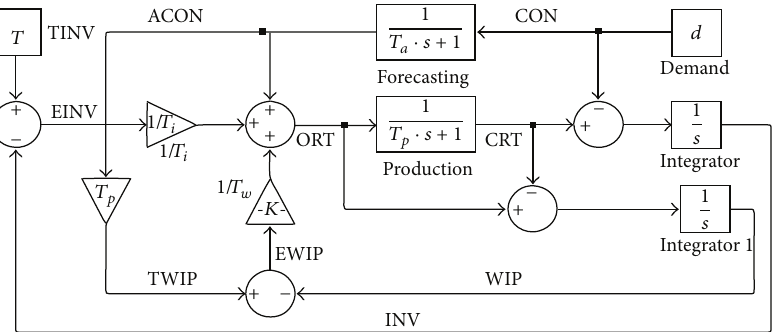
Figure 4: Block diagram of APIOBPCS model.